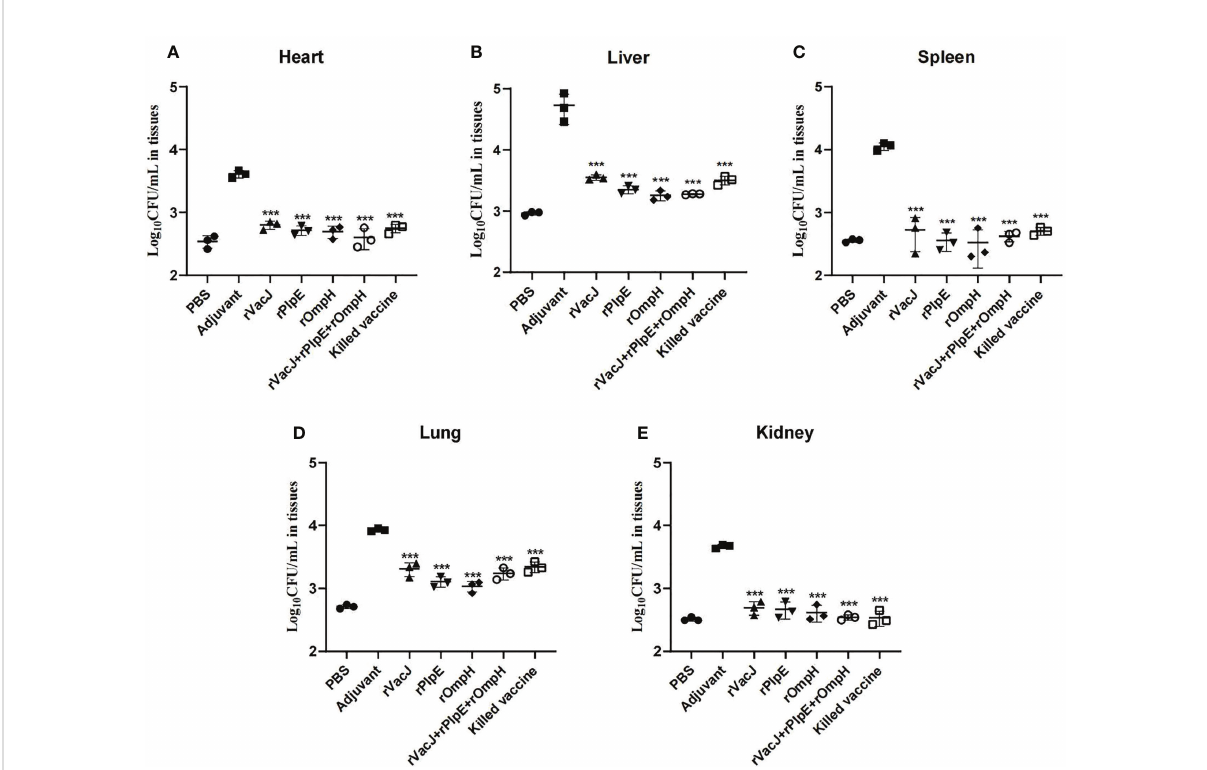
FIGURE 4 Bacterial loads in various organs are determined by qRT-PCR. The bacterial loads of each vaccination group (n=3/group) in the heart (A) , liver (B) , spleen (C) , lung (D) and kidney (E) were determined as CFU/mL at 24 h post-challenge. The PBS group was blank control group (not challenged with PMWSG-4 strain). *** is